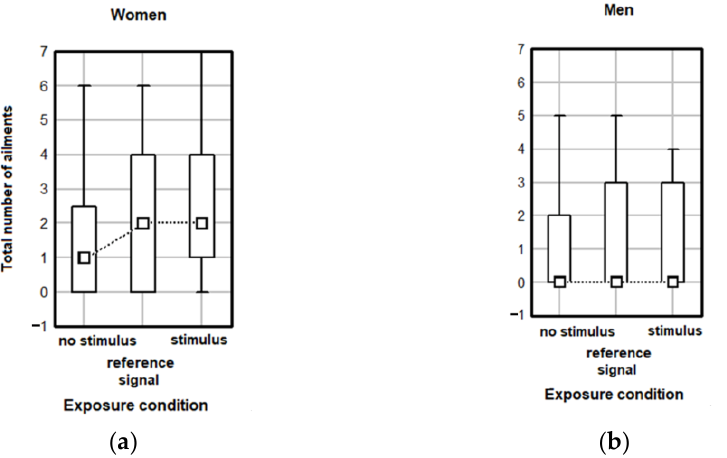
Figure 6. Total numbers of post-exposure feelings reported in various exposure conditions by ( a ) female and ( b ) male students. Data are given as median values with 5th, 25th, 75th and 95th percentiles.